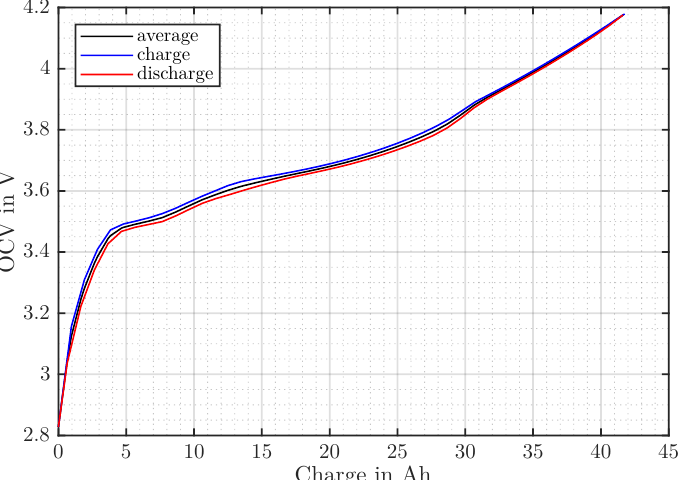
Figure 3. Exemplary measurement results for the OCV curve of NMC pouch cells recorded at a cell temperature of 22°C.